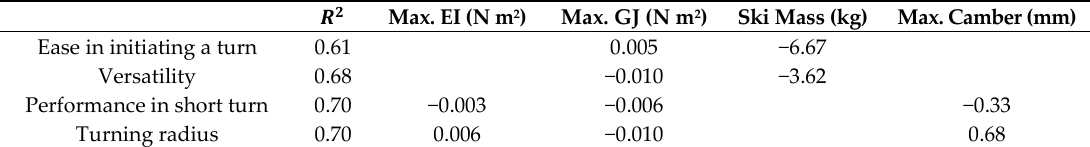
Table 1. Linear regression coefficient for each significant